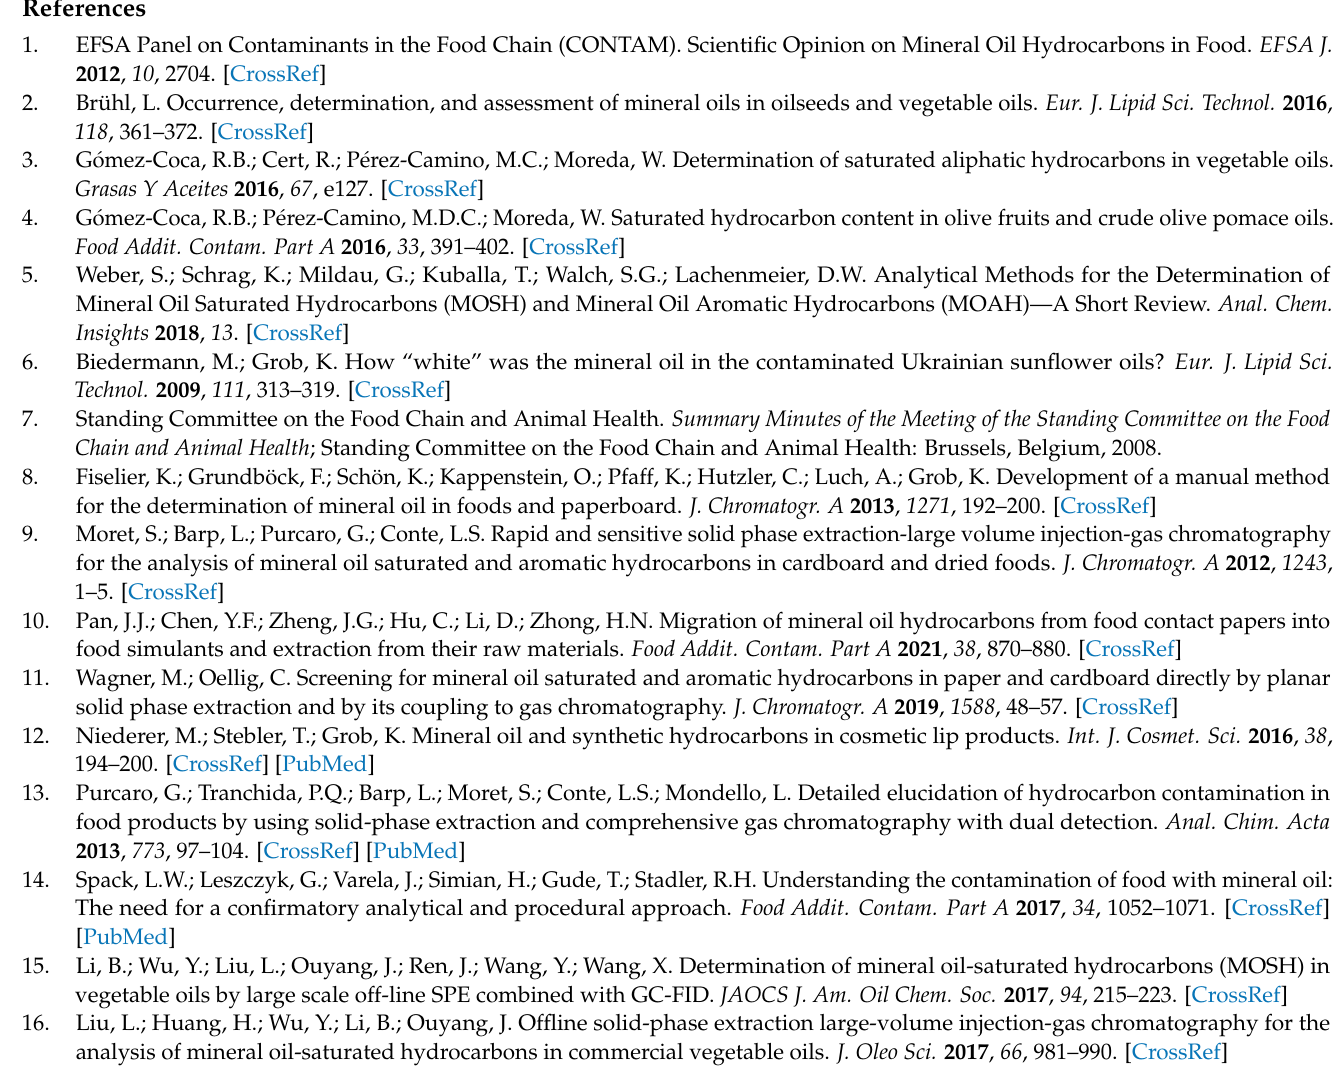
Figure S2: Comparison of the peak areas between the minimum (a) and maximum (b) temperatures of the injector and FID (c) tested. Table S1. Calibration curves and R2 obtained, by ranges, of MOH. Table S2: Concentration by ranges of MOH detected in the samples of edible oils